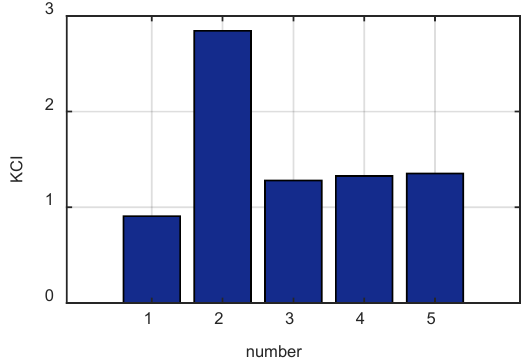
Figure 9. Histogram of the recombination model obtained by KCI.